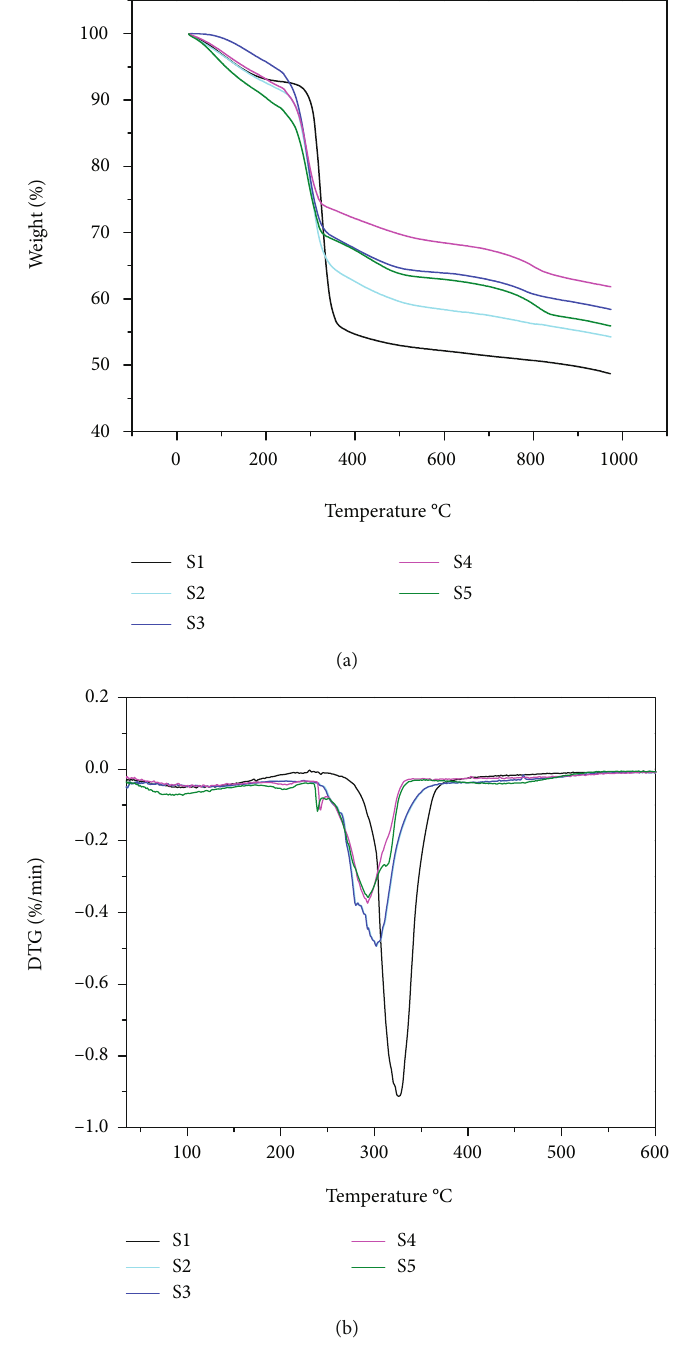
Figure 5: (a) Weight loss. (b) DTG. Film samples (S1-100/0, S2-75/25, S3-50/50, S4-25/75, and